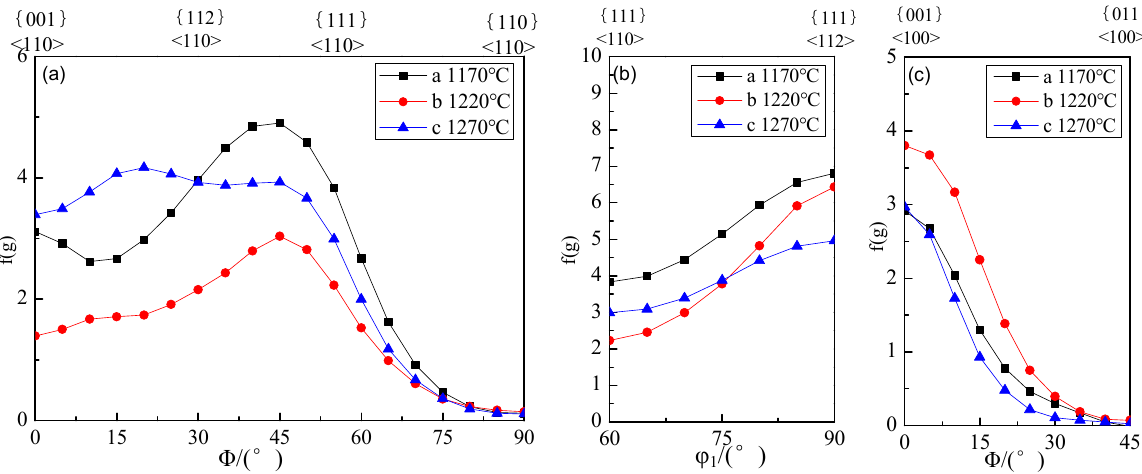
Figure 7. Orientation distribution intensities along ( a ) α -fiber, ( b ) γ -fiber, and ( c ) η -fiber after annealing with different slab heating temperatures.